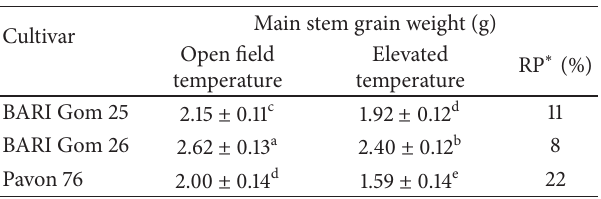
∗ RP = reduction percentage relative to open field temperature condition. Thevalueshavebeengivenasarithmeticmean ± SE.Valuesinacolumnwith different letters are significantly different at 𝑃 ≤ 0.05 by